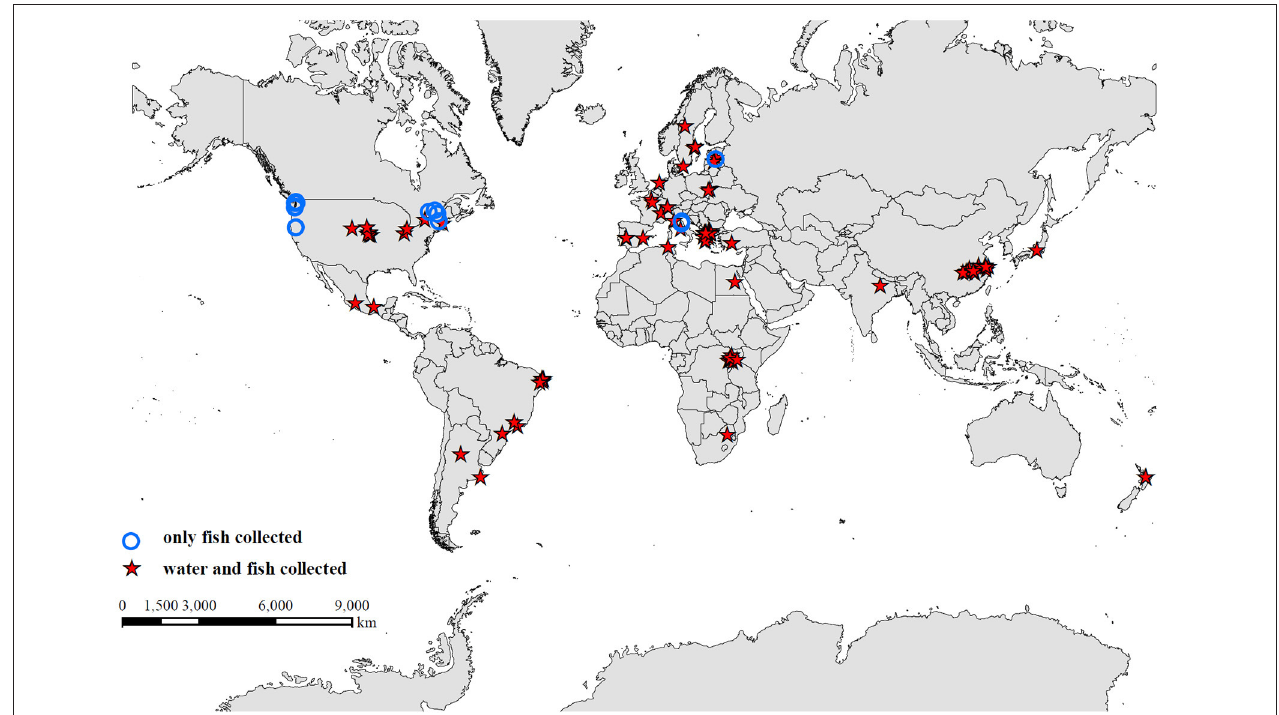
FIGURE 1 | Global distribution of 99 freshwater systems, including lakes, ponds, and reservoirs, from studies used in the data synthesis. Studies that collected fish and water samples concurrently are identified by a red star, and studies that collected only fish samples are indicated by a blue